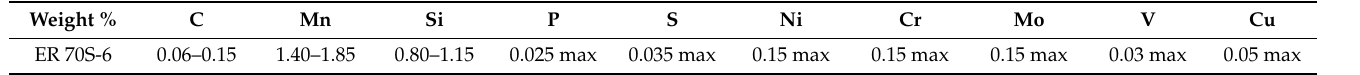
Table 3. Mechanical properties of welding wire grade AWS A5.18 ER 70S-6. Table 4. Chemical composition of welding wire grade AWS A5.18 ER